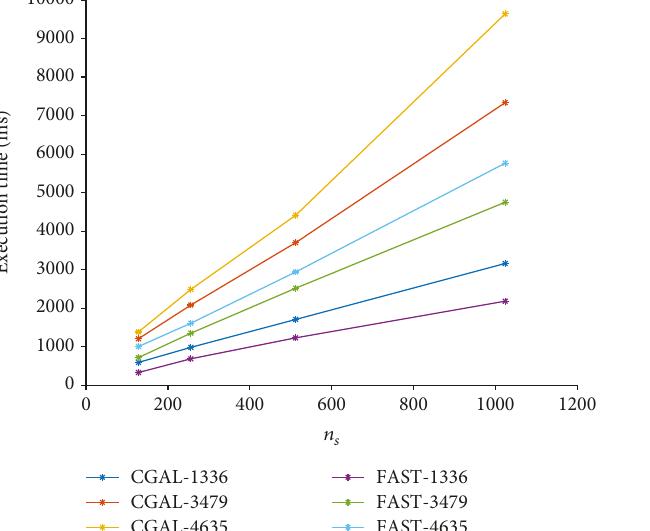
Figure 15: Parallel sampling point-generating pro fi ling data.